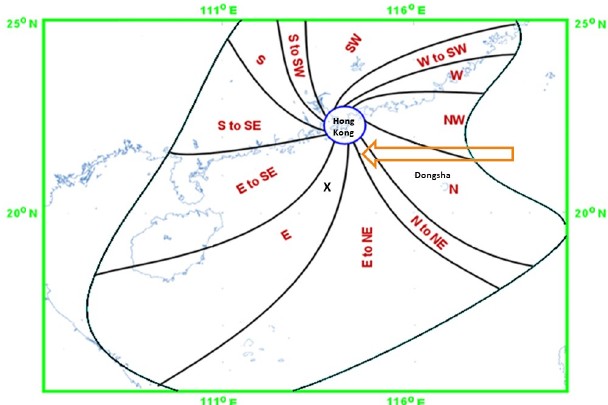
Figure 5. The 12-segment reference diagram showing the correla- tion between the wind direction for wind strength of strong force or above at Waglan Island and the tropical cyclone position used by the Hong Kong Observatory (for example, the winds at Waglan Is- land will be easterly when the tropical cyclone is located at position “X”). The arrow framed in brown shows the typical track of a trop- ical cyclone that could cause a sequential change in wind direction in Hong Kong similar to that of the passage of Typhoon